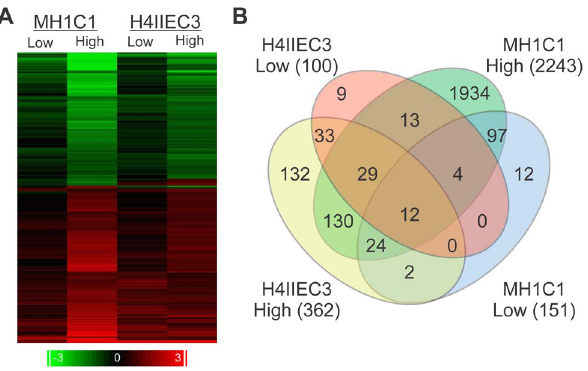
Figure 1. Differentially expressed probe sets. A total of 2,431 probe sets are differentially expressed at a FDR , 0.01 and a 1.8 fold change cut off in at least one condition. The 212 probe sets that are differentially expressed in both cell lines are shown in the heat map with the log 2 ratio of change displayed.